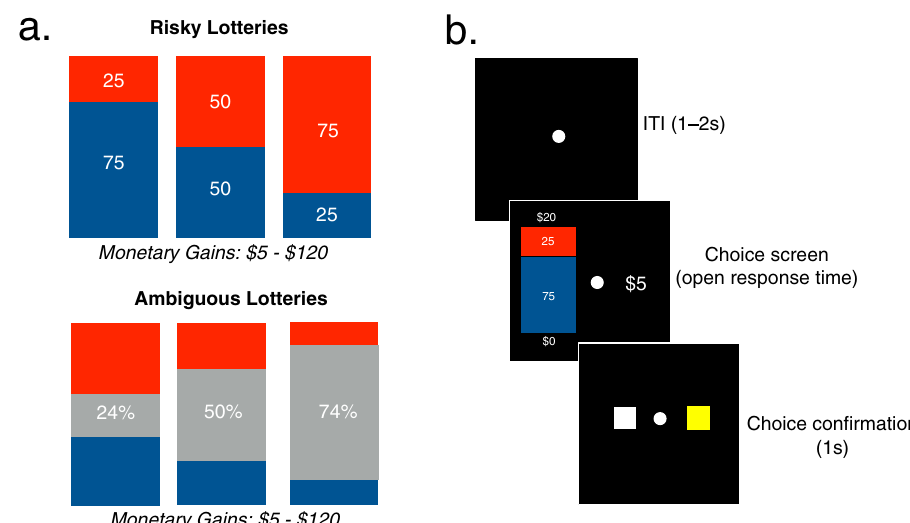
Fig. 1 Task design. a All risky (top) and ambiguous (bottom) lottery bags used in the experiment. b Example trial sequence. Here, the participant chose between receiving $5 for sure or a lottery with a 25% chance of winning $20 and a 75% of winning